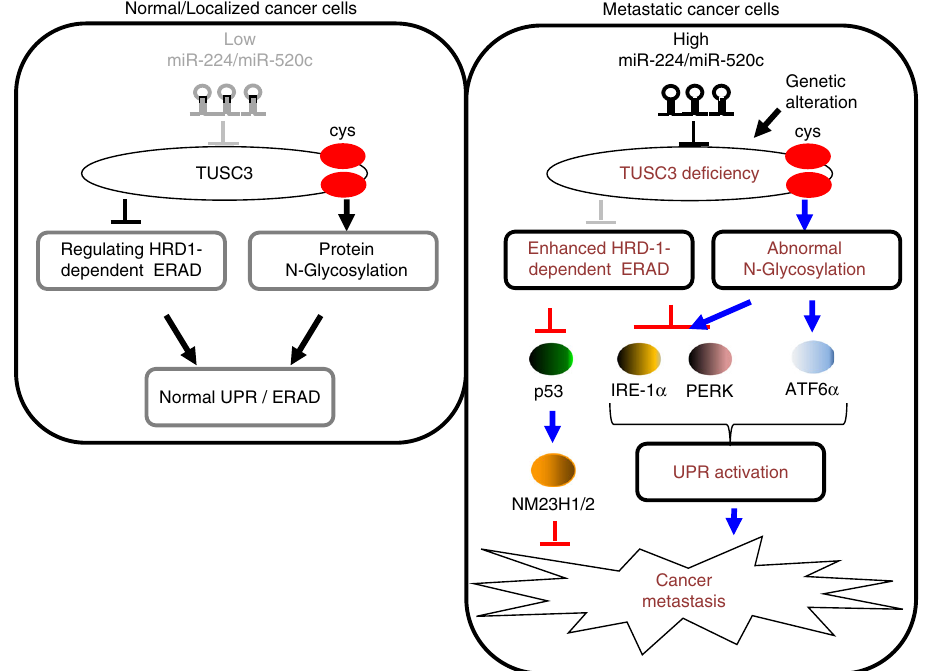
Fig. 6 The schematic diagram showing the working hypothesis by which miR-224/-520c-induced TUSC3 suppression enhanced metastatic potential of NSCLC through the alteration of UPRs and HRD1-dependent